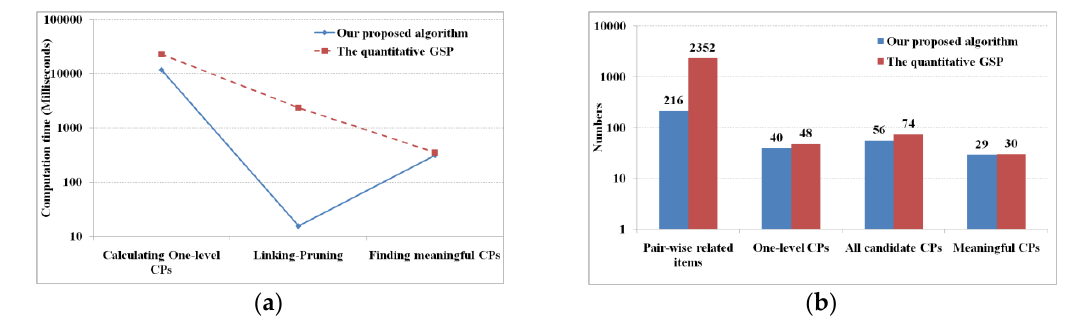
Figure 8. Comparisons of the quantitative GSP and our proposed algorithm. ( a ) Computation time during the different mining phases; ( b ) Number of pair-wise related items, one-level cascading patterns, all candidates of cascading patterns, and the meaningful cascading